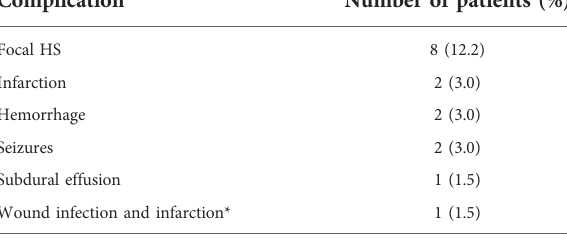
TABLE 2 Perioperative